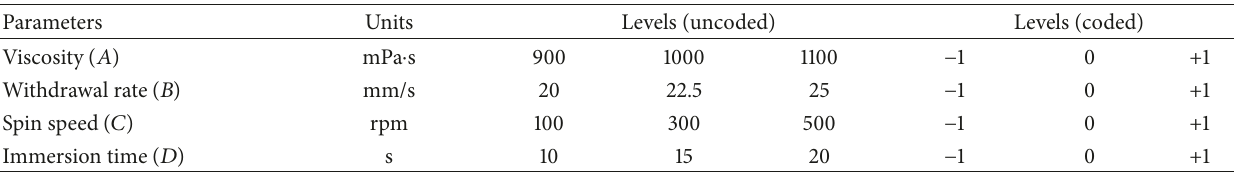
Table 1: Coating parameters used in the 2 𝑘 factorial experiments.